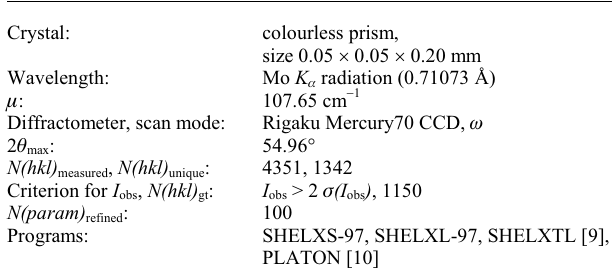
Table 1. Data collection and handling.